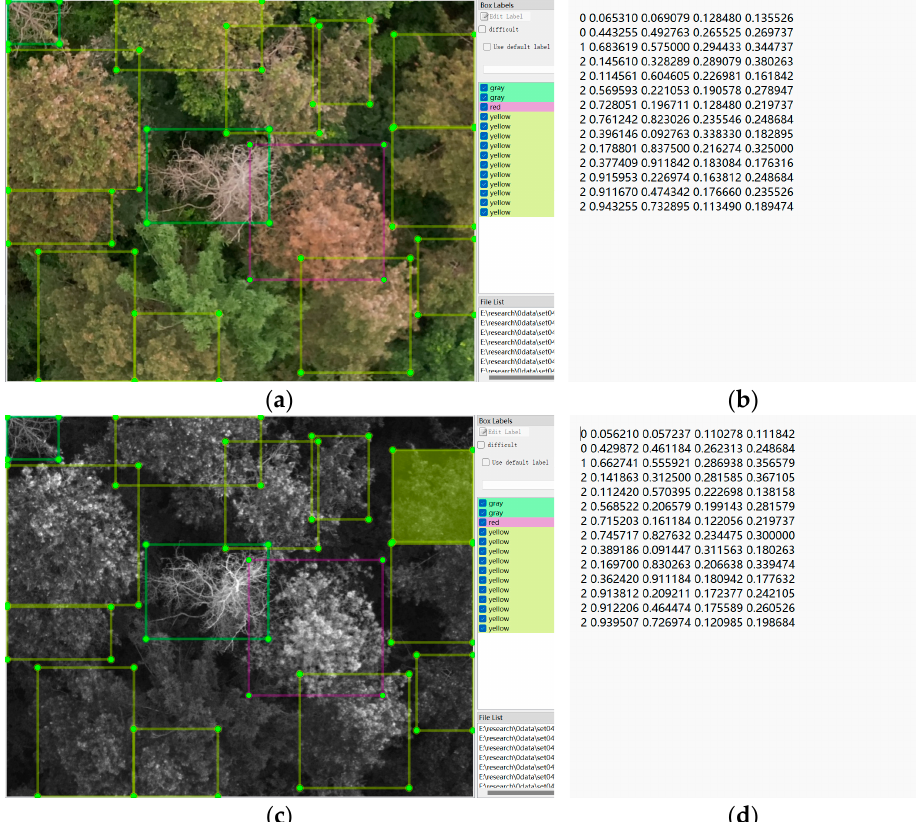
Figure 4. Data annotation, ( a ) labeling visible images, ( b ) annotation files of visible image, ( c ) labeling red-band images, and ( d ) annotation files of red-band image.